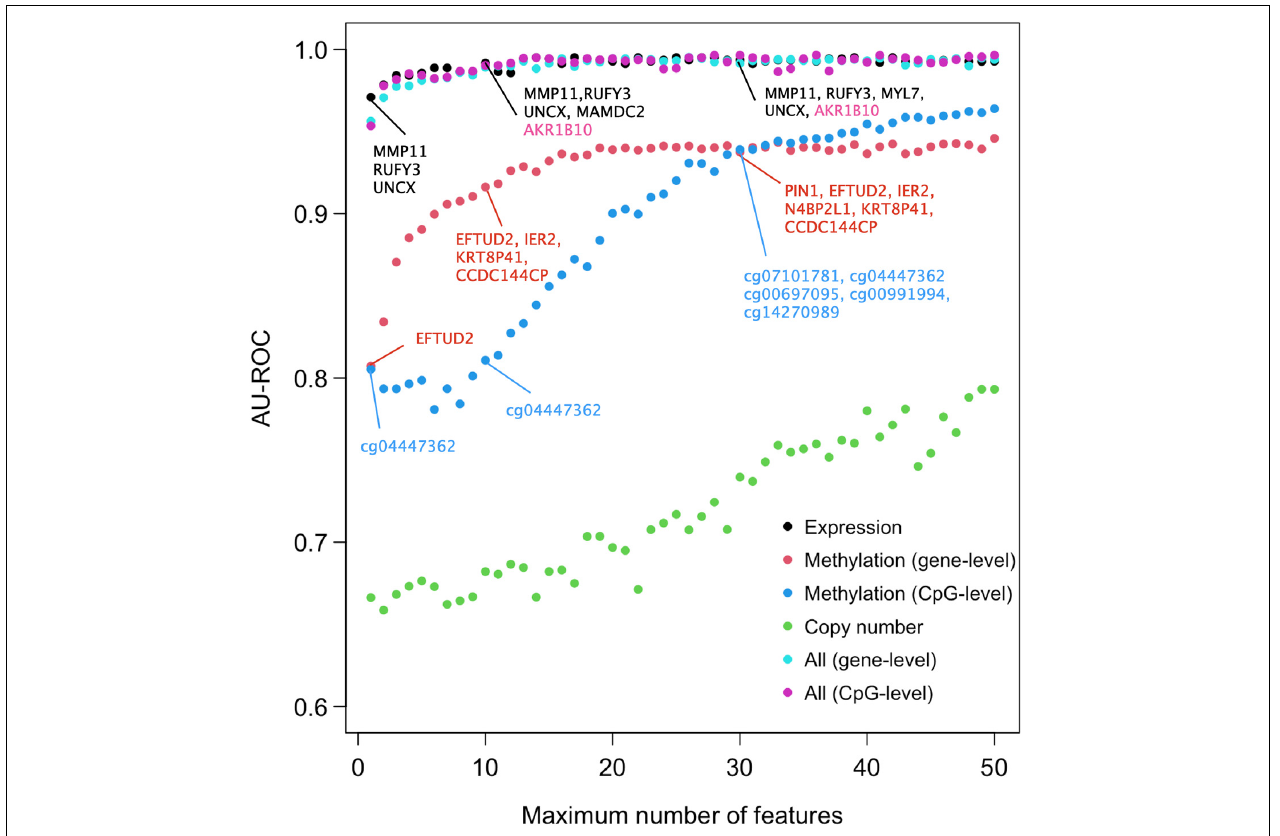
FIGURE 2 | Predictive accuracy of the omics profiles and their combinations when the maximum number of features was limited. The points are average AU-ROC values over the 10 CV rounds in nested CV. Example feature sets from omics data are shown at limits x = 2, 10, and 30. The gene lists contain the features that were selected by Lasso in all the 10-fold at that limit. Expression data and integrated data share most genes in common. Black color indicates genes that were selected by both gene expression and integrated data, the pink color those genes that were selected by integrated data only. Note that the top genes of the two types of integrated data are the same. No copy number features were selected in all the 10 CV folds (no robust CNV features). See Supplementary Figure 4 for the version of ROC and PRCs with SEMs included.